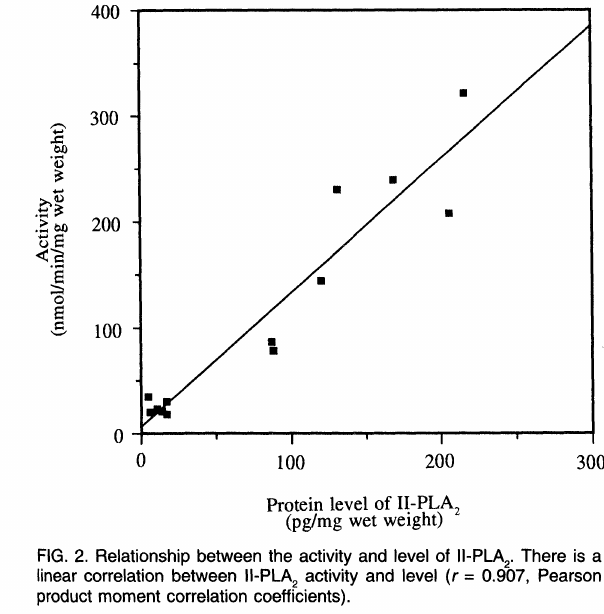
FIG. 2. Relationship between the activity and level of II-PLA There is a linear correlation between II-PLA2 activity and level (r 0.907, Pearson product moment correlation